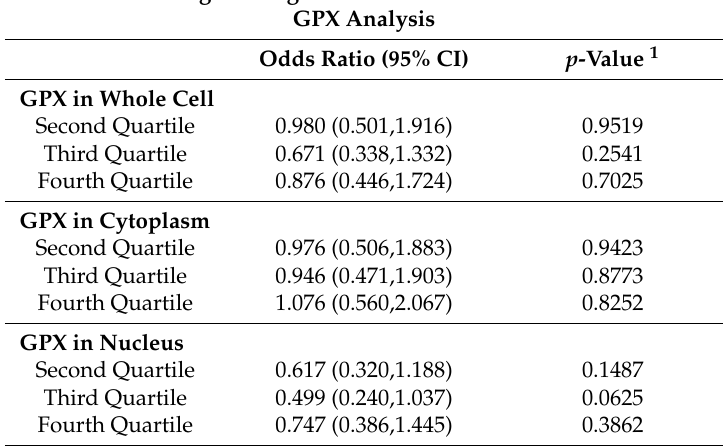
Table 1. For each individual, the average of the total GPX1 level per cell was calculated. Conditional Logistic Regression of Prostate Cancer Recurrence GPX Analysis Odds Ratio (95% CI) p -Value